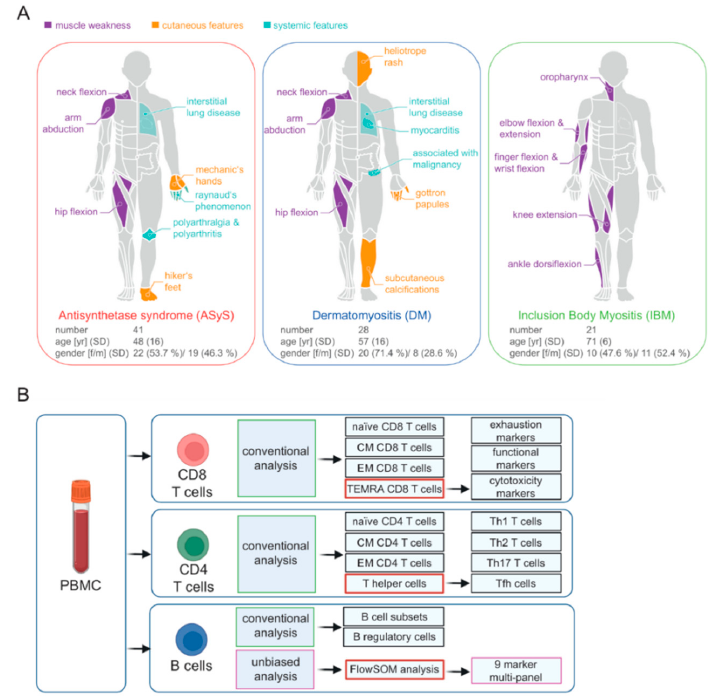
Figure 1. Overview of the patient cohort and analyzed flow cytometry panels. ( A ) Clinical phenotypes and characteristics of ASyS, DM and IBM. ( B ) Overview of flow cytometry panels analysed in the study. PBMC were analysed by flow cytometry. The CD8 and CD4 T cell compartment were analysed by conventional gating. TEMRA CD8 T cells and T helper cells were then analysed in further detail. B cells were investigated by conventional analysis and by unbiased analysis using FlowSOM. Abbreviations: ASyS = anti-synthetase syndrome; DM = dermatomyositis; IBM = inclusion body